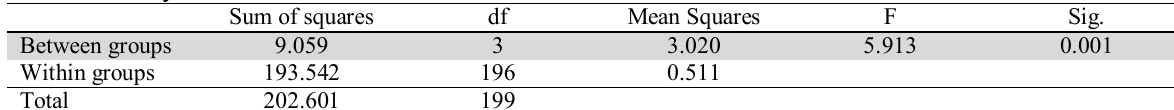
The summary of ANOVA test Sum of squares df Mean Squares F Sig. Between groups 9.059 3 3.020 5.913 0.001 193.542